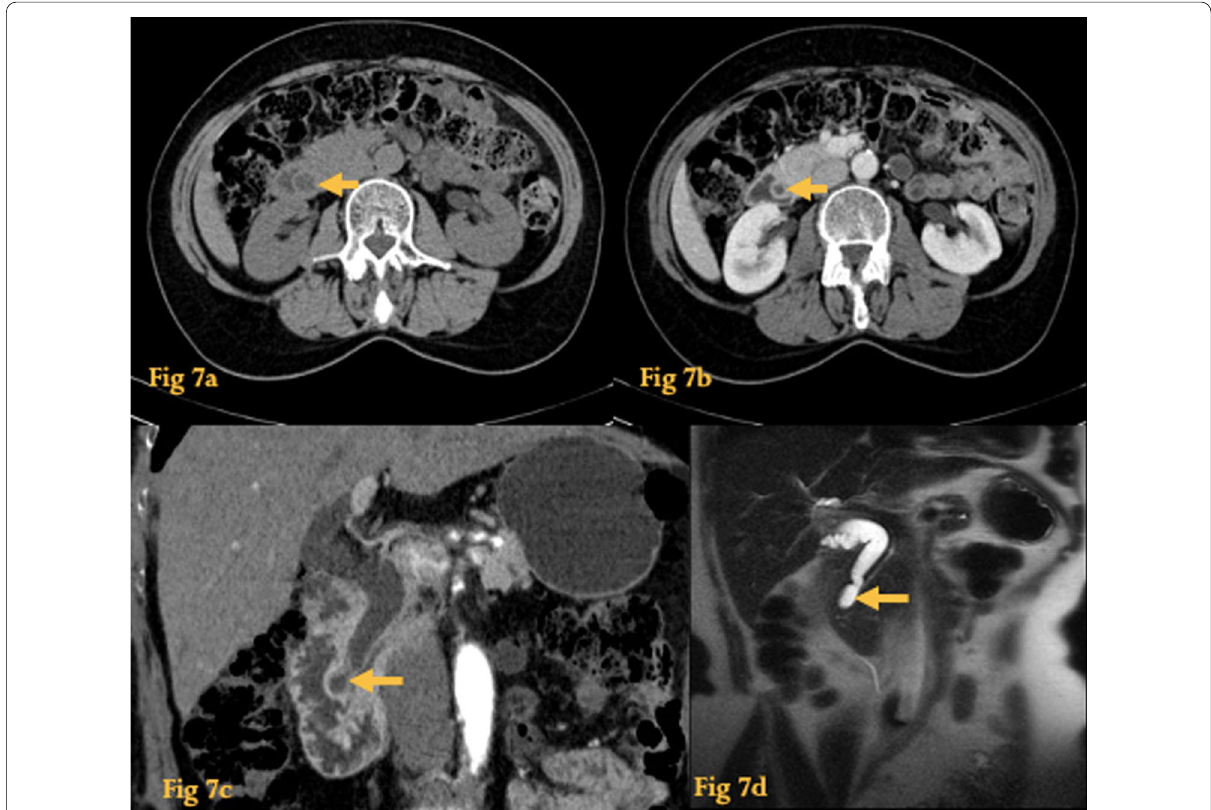
Fig. 7 Choledococele. Unenhanced ( a ) and enhanced CT ( b ) shows a fluid‑filled sac within the medial wall of the descending duodenum. CT coronal reformation ( c ) shows protrusion of a dilated distal segment of the common bile duct into the duodenum. Abdominal MR ( d ), coronal HASTE heavily T2‑weighted sequence, shows distal CBD dilatation which protrudes into the